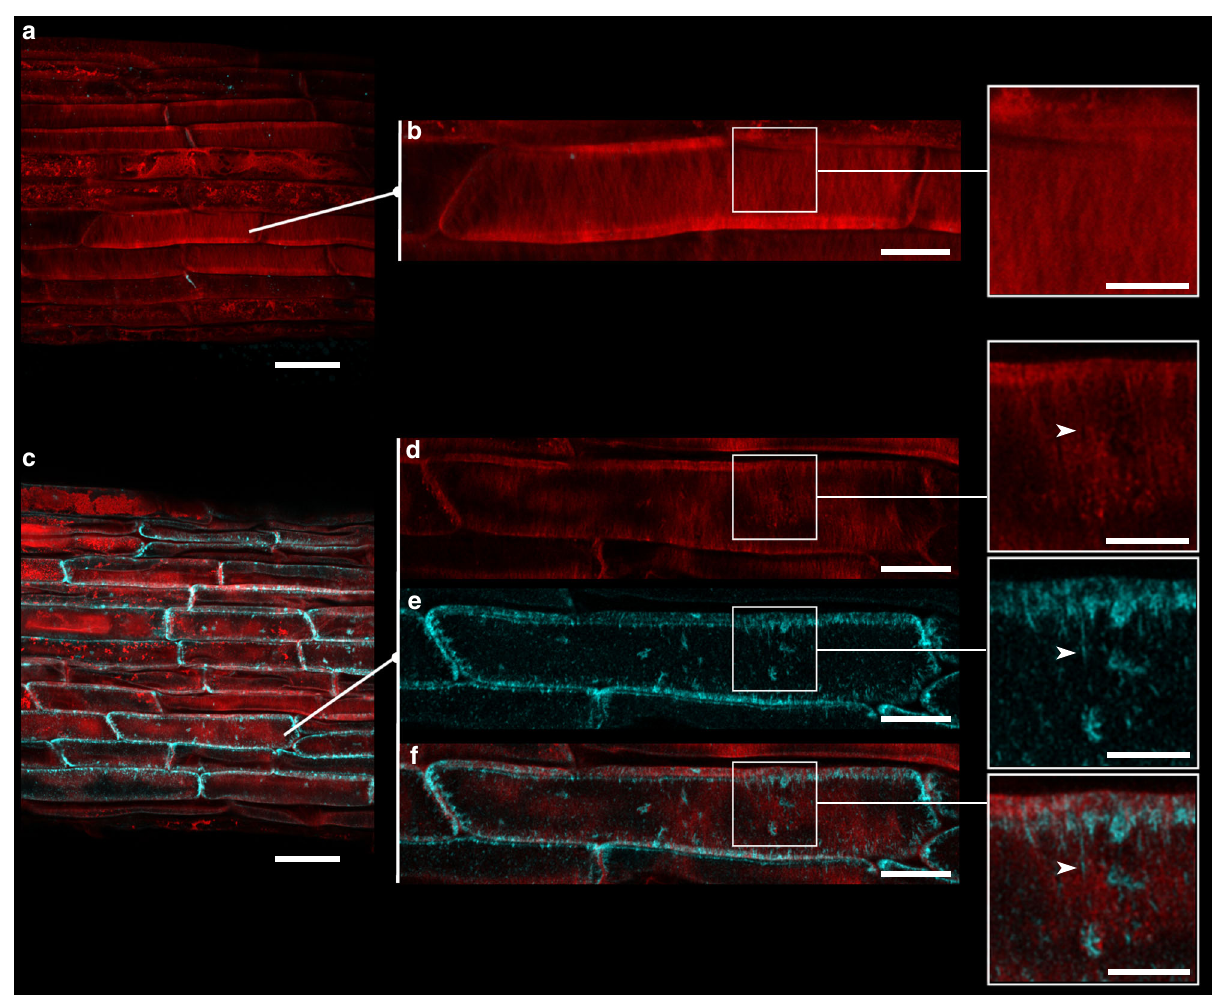
Fig. 8 Induction of pG1090::icals3m increases callose which decorates cellulose micro fi brils. DMSO-treated and estradiol-treated icals3m roots were co- stained with aniline blue (cyan) and direct red 23 (red) which fl uorescently stain callose and cellulose, respectively. a , b show confocal images of a region in the elongation zone of the root 24 h after treatment with DMSO (control). b and close-up show the merged signal at higher magni fi cation. c – f show comparative regions in icals3m roots 24 h after estradiol induction (activation of icals3m ). Notice the increased accumulation of callose (cyan signal) in c comparing to a . Consult also Supplementary Fig. 9. d , e and f show enlargements of a cell from c , with their associated close-ups in the separate channels ( d , direct red 23); e , aniline blue and f , merged image). Arrowhead highlights an area where callose integrates very closely to cellulose micro fi brils. Scale bars ( a , b ) = 25 µ m; ( b , d , e , f ) = 10 µ m; ( b , d , e , f close-ups) = 5 µ m